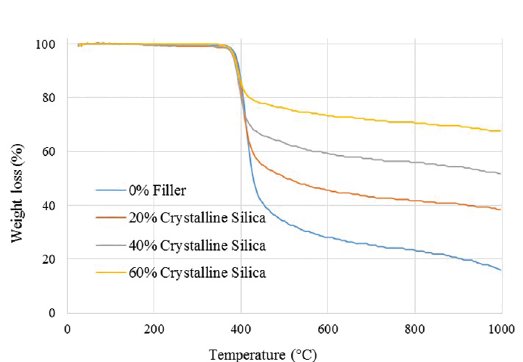
Figure 9. Thermogravimetric analysis of the mixtures prepared with 20, 40, and 60% (wt) RHA-FB